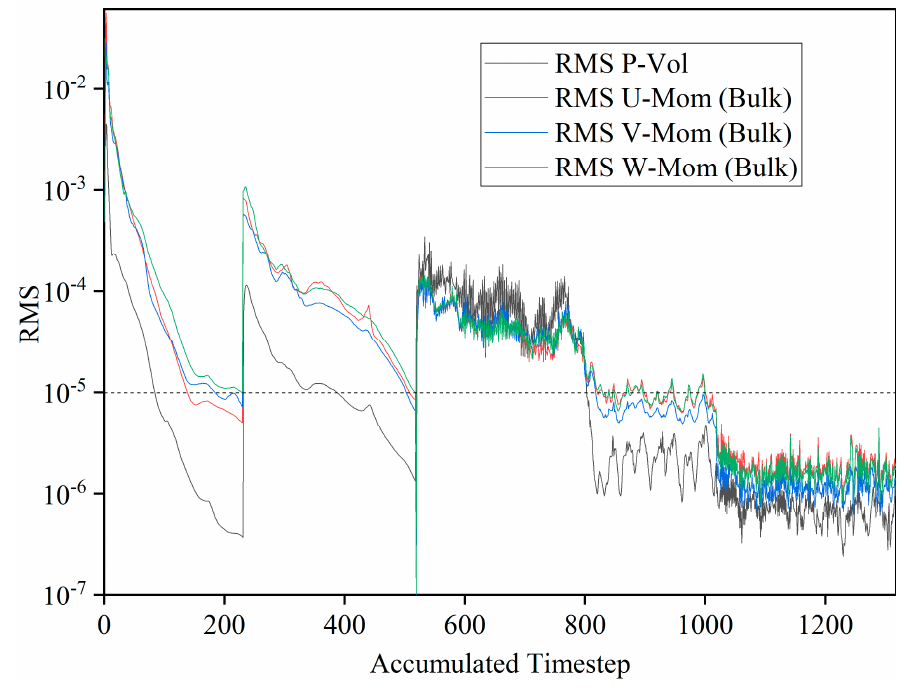
Figure 4. The convergence process of WALE model.